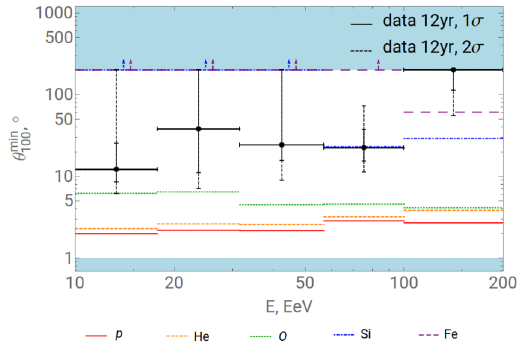
Figure 4. Comparison of the pure composition models (color lines as indicated on the plot) with the TA data (black crosses). Upward arrows indicate model predictions indistinguishable from isotropy.